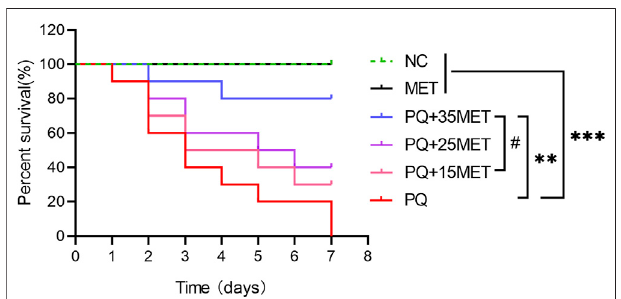
TABLE 1 | Primer sequences used for qRT-PCR.